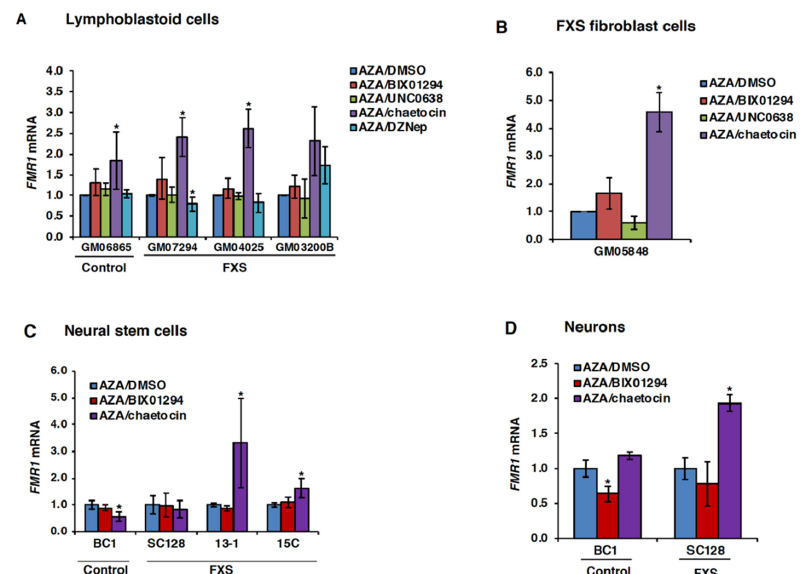
Figure 3. E ff ect of HMT inhibitors on FMR1 gene expression after pretreatment with AZA in human lymphoblastoid cell lines ( A ), FXS fibroblast cell line ( B ), neural stem cells ( C ) and neurons ( D ). Lymphoblastoid and fibroblast cells were treated with 10 µ M AZA for 72 h followed by either DMSO or indicated HMT inhibitors (4 µ M of BIX01294, 100 nM chaetocin, 0.5 µ M UNC0638 or 5 µ M DZNep) for the next 48 h and harvested for total RNA on day 5. The neural stem cells and neurons were treated with 0.5 µ M AZA for 72 h and recovered in drug-free medium for 24 h, followed by treatment with indicated inhibitors for 48 h and harvested for total RNA on day 6. The levels of FMR1 mRNA and GAPDH mRNA were analyzed by RT-qPCR. The FMR1 mRNA levels were first normalized to GAPDH mRNA levels and are shown relative to the levels in AZA / DMSO at day 5 ( A , B ) or day 6 ( C , D ). Data shown are an average of at least three independent treatments, and error bars represent standard deviation. Statistically significant di ff erences are indicated by an asterisk ( p < 0.05).